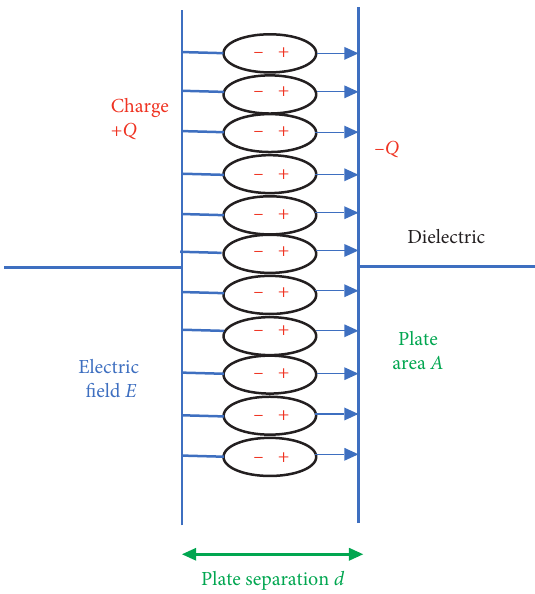
Figure 1: Structure of the dielectric